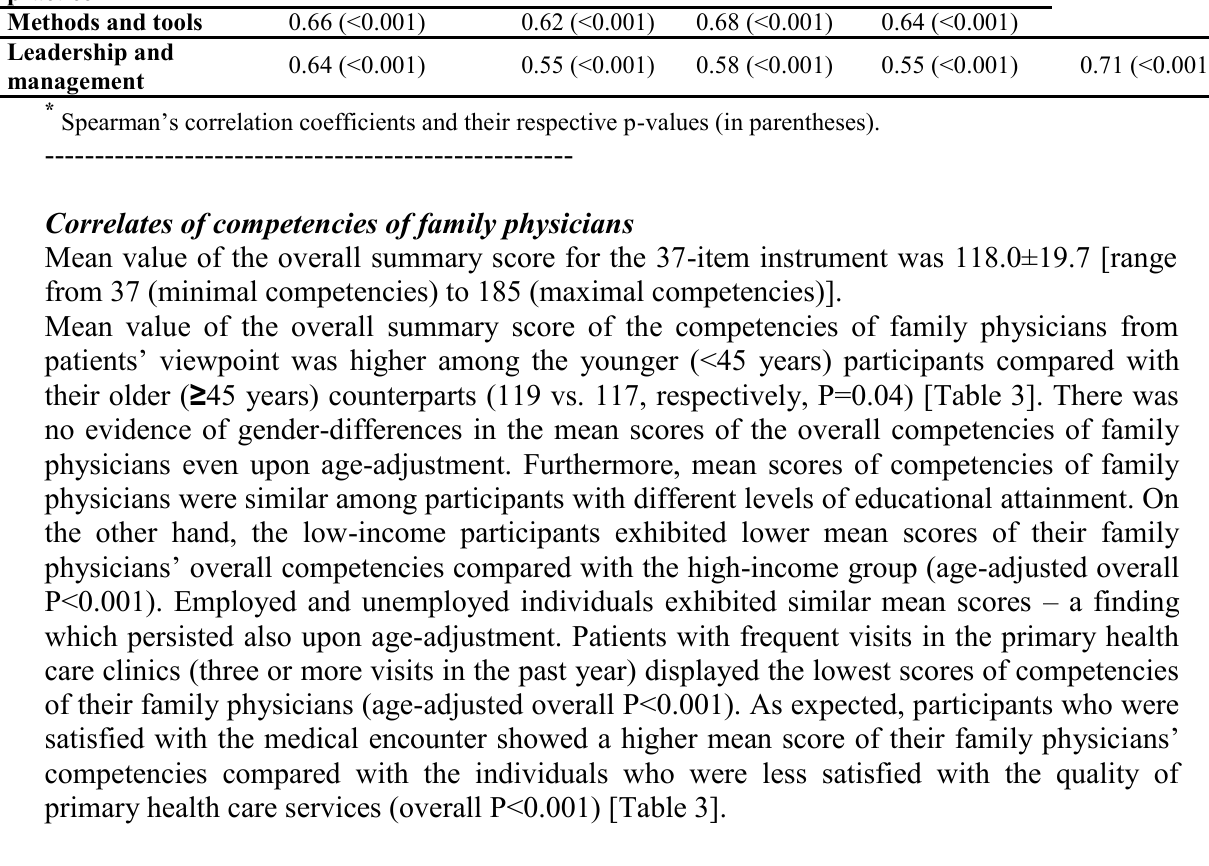
Table 3. Association of competencies of family physicians from patients’ viewpoint with their demographic and socioeconomic characteristics; mean values from the General Linear Model Patients’